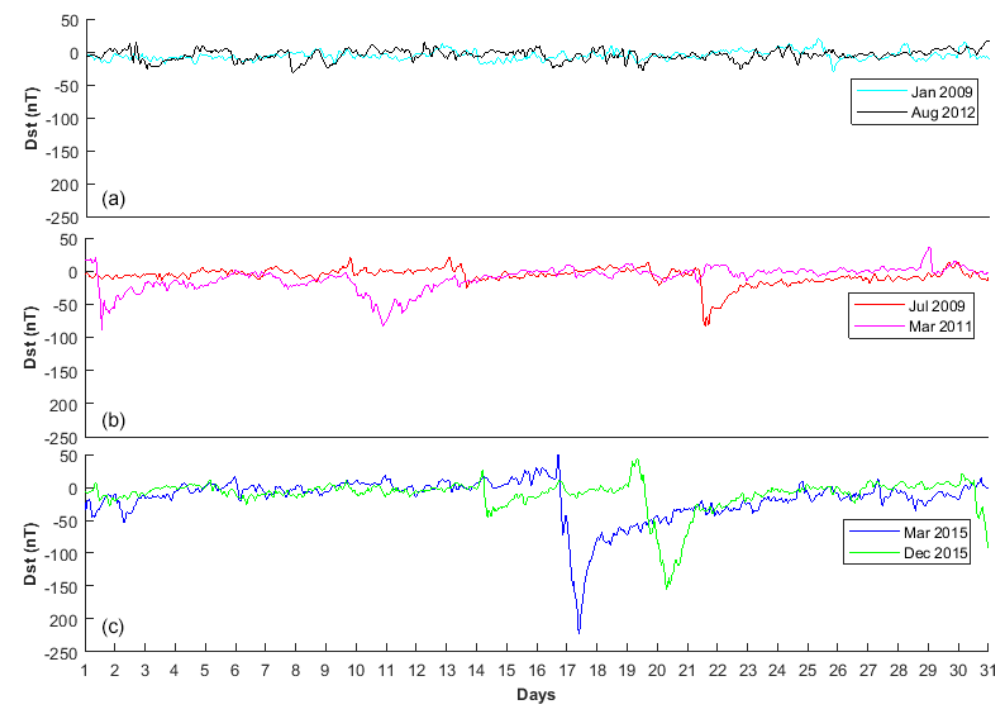
Figure 1. Samples of D st signals classified as (a) minor, (b) moderate and (c) major geomagnetic storms.